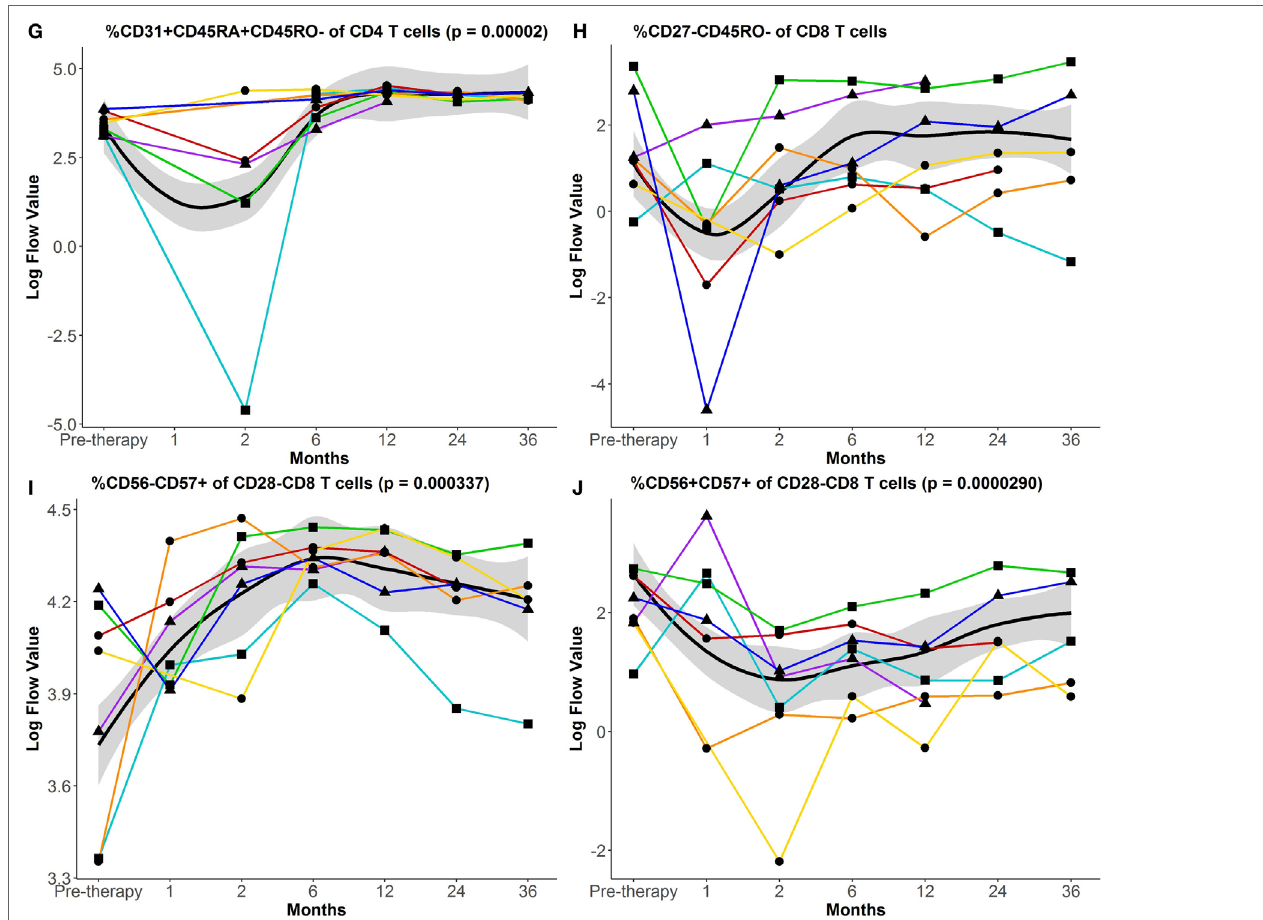
FigUre 2 | Impact of autologous hematopoietic stem cell transplantation (AHSCT) on the composition of circulating CD4 and CD8 T cells through 36 months follow-up. Percentages of CD27 + CD45RO − naive CD4 (A) and CD8 (B) T cells, CD27 + CD45RO + central memory CD4 (c) and CD8 (D) T cells, CD27 − CD45RO + effector memory CD4 (e) and CD8 (F) T cells, (g) CD31 + CD45RA + CD45RO − CD4 recent thymic emigrants (RTEs), (H) CD27 − CD45RO − long-term memory CD8 T cells, (i) CD56 − CD57 + CD28 − CD8 T cells, and (J) CD56 + CD57 + CD28 − CD8 T cells. Flow data were plotted after log transformation for normalization of these variables. Data shown are mean values for the group that maintained remission through 60 months post-AHSCT. The black line represents the Loess Regression fitted curve with a span = 0.7, and its 95% confidence band colored in gray. Paired t -test was used to examine sustained changes at 36 months from pretherapy numbers within the group that maintained remission through 60 months post-AHSCT (n = 15). AHSCT induced persistent changes in relative proportions of central memory and RTE phenotypes in reconstituted CD4 T cells. In reconstituted CD8 T cells, sustained alterations in proportions of central memory, CD56 − CD57 + CD28 − (senescent) and CD56 + CD57 + CD28 − (cytotoxic) phenotypes were observed. Individual lines for the seven participants who experienced disease reactivation before 60 months post-AHSCT are plotted using different symbols to indicate the type of disease activity and different colored lines to indicate the time to first multiple sclerosis (MS) disease activity. For additional details including flow cytometry data without log-transformation, see https://www.itntrialshare.org/HALTMS_fimmu_